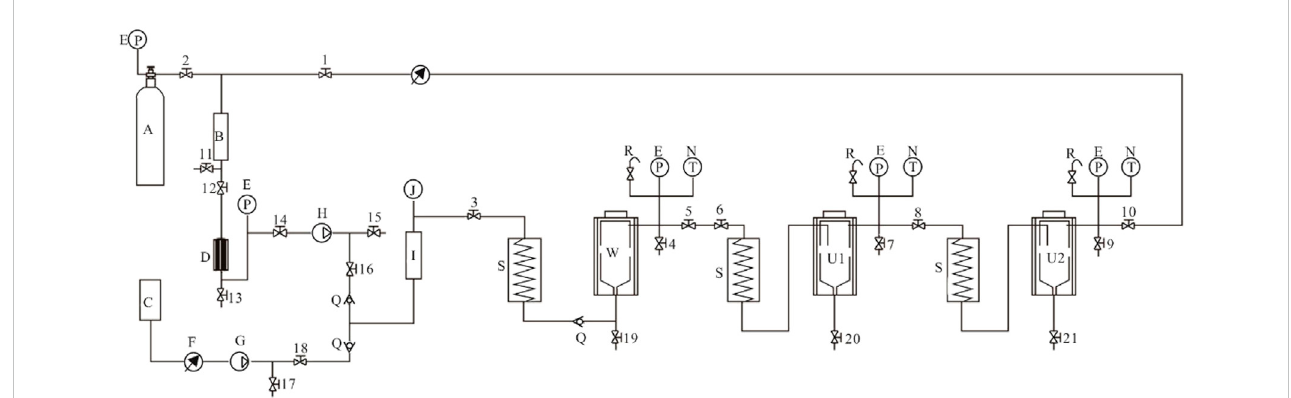
FIGURE 2 The fl owchart ofSC-CO 2 extractionexperiment. (A) CO 2 cylinder; (B) Puri fi er; (C) Carrydosebucket; (D) Cold condenser; (E) Pressuregauge; (F) Carrier fl owmeter; (G) Carrier pump; (H) High pressure CO (I) Mixer; (J) Electric contact pressure gauge; (N) Thermometer; (P) CO 2 pump; valve; (R) Safety valve; (S) Pre-heater; U1: Separation kettle; (W) Extraction kettle; 1 – 5, 7 – 21: Stop valve; 6: Regulating valve.